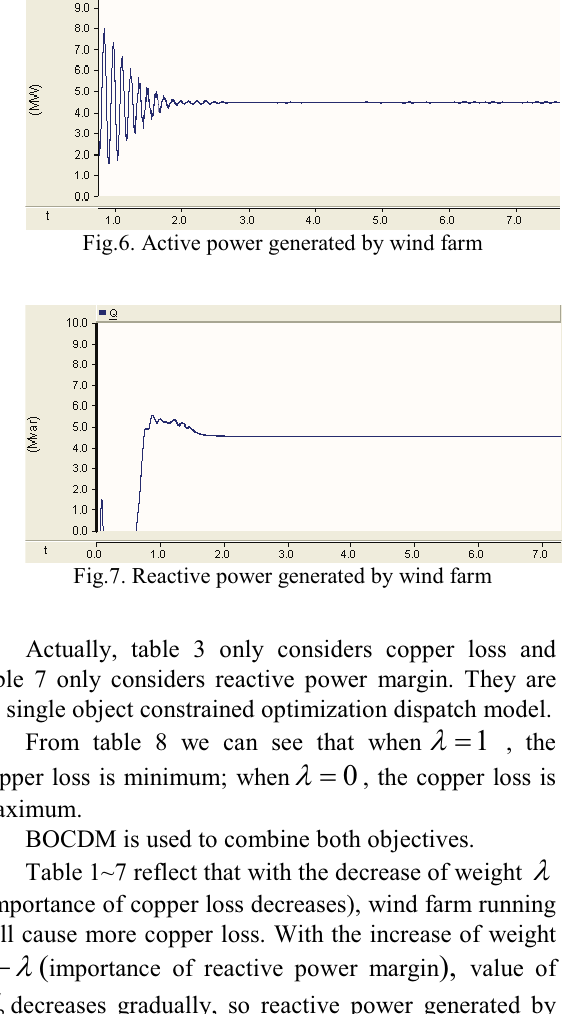
Table 4. Active power and reactive power